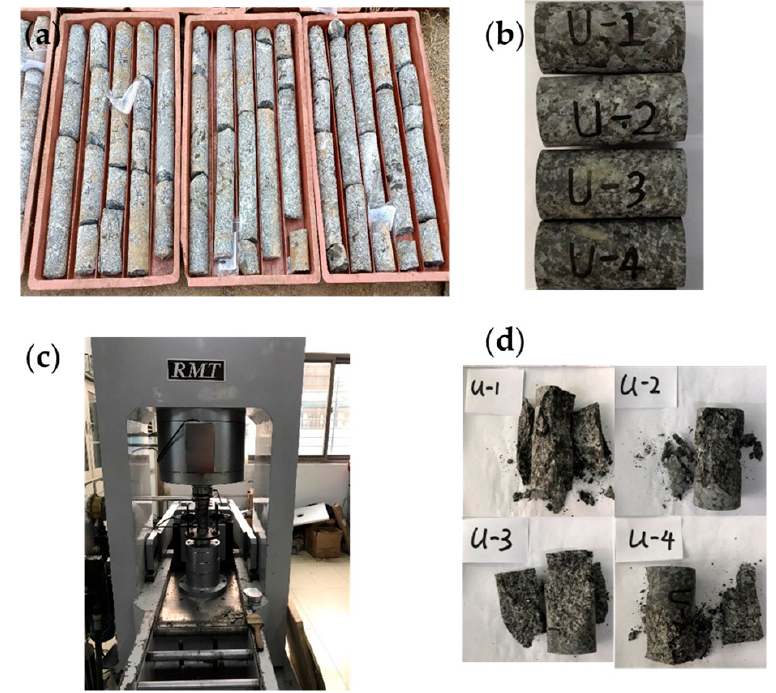
Figure 2. Uniaxial compression test: ( a ) field coring; ( b ) test piece; ( c ) RMT-150C; ( d ) damaged test piece(Test piece No.: U-1~U-4).